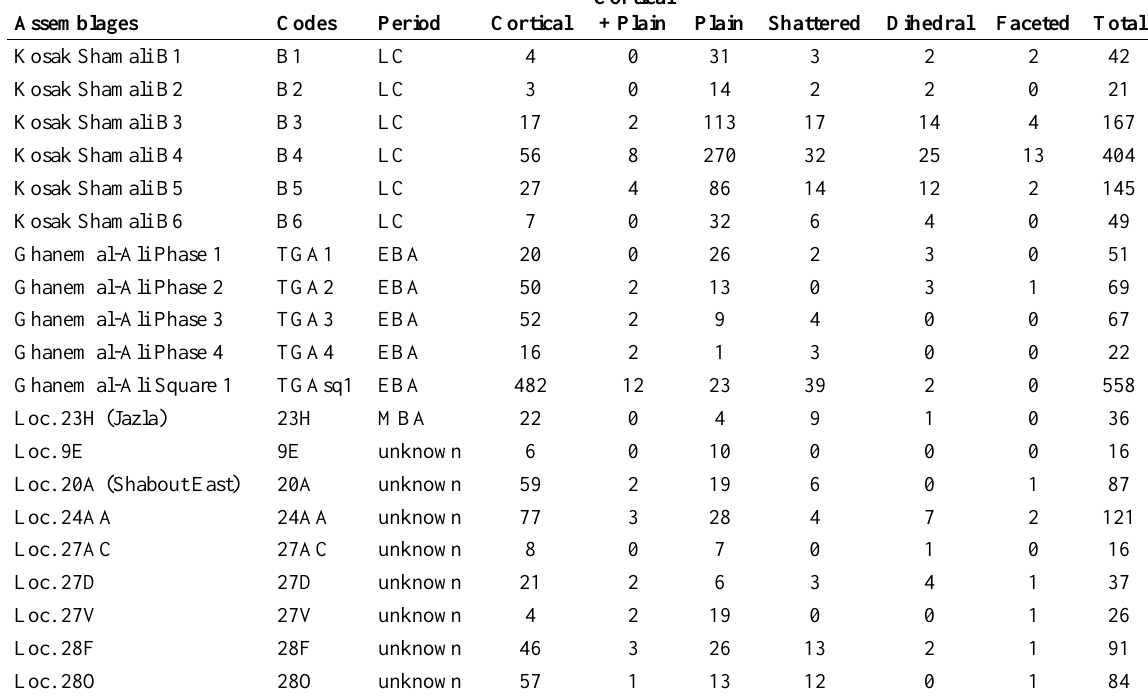
Cortical + Plain Plain Shattered Dihedral Faceted Total